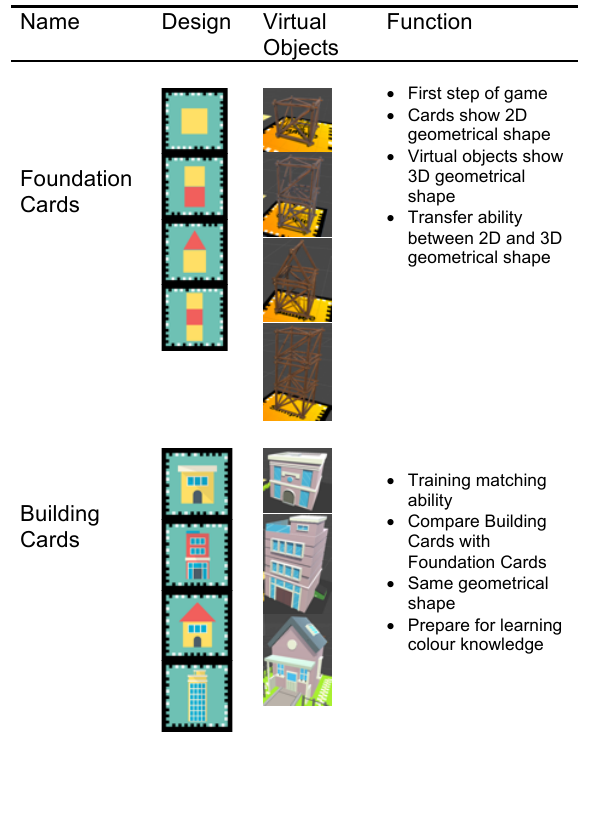
Table 2. Different tangible blocks or cards design